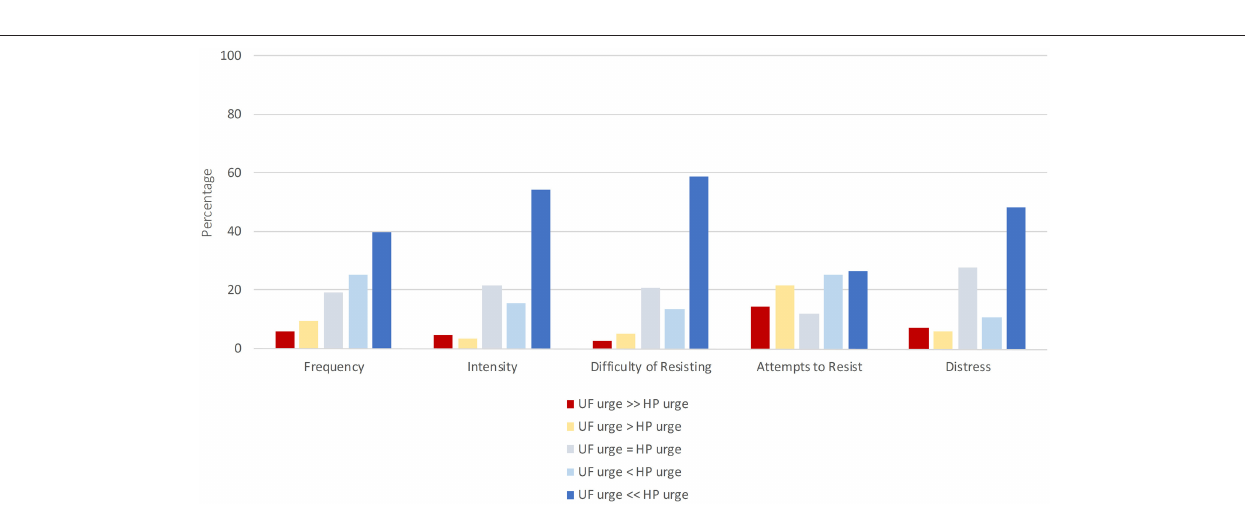
states over time are shown for the UF + group in Figure 3